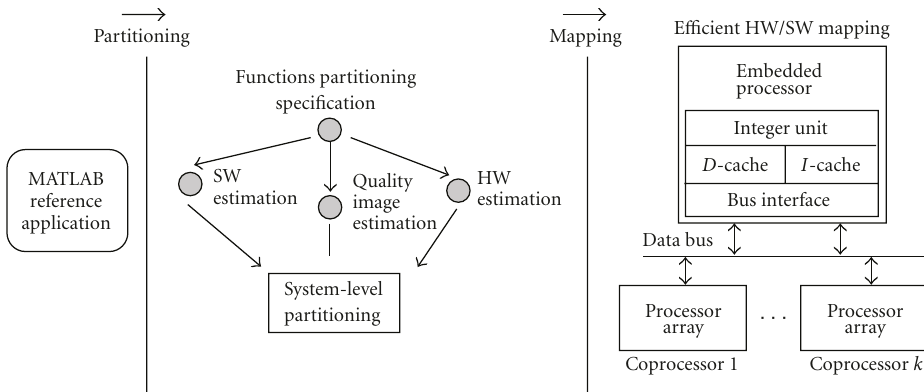
Figure 3: Illustration of the HW/SW codesign